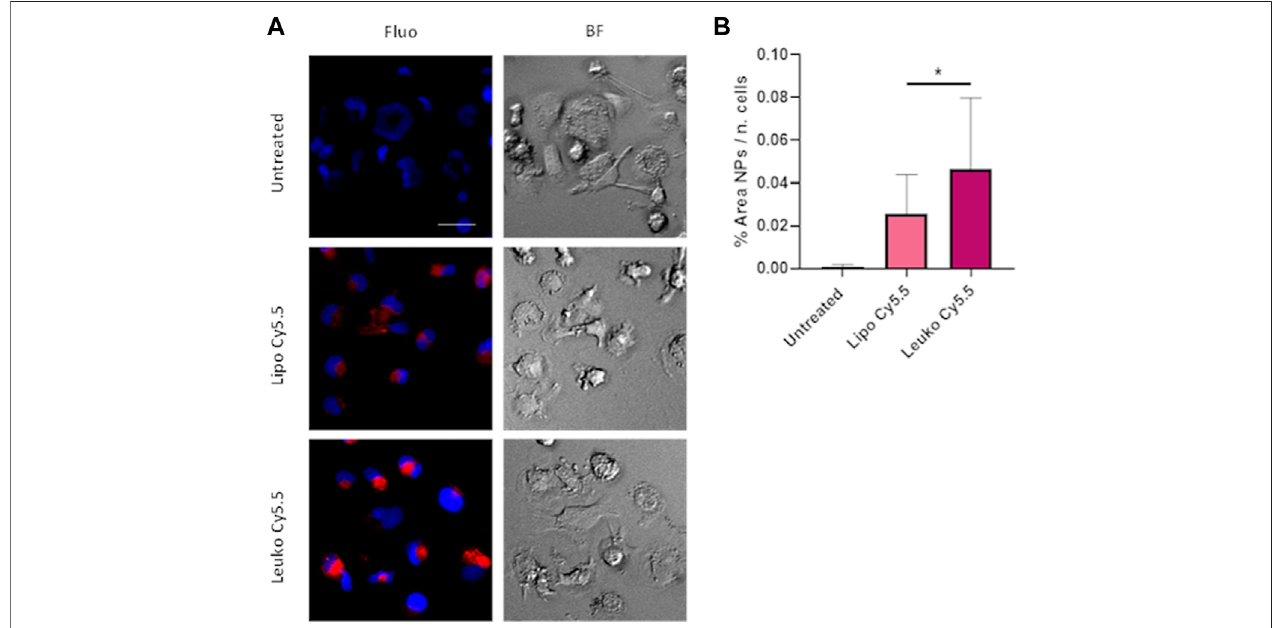
FIGURE 7 | (A) Fluorescence (Fluo) and respective bright fi eld (BF) images of THP-1 derived macrophages treated with either Lipo Cy5.5 or Leuko Cy5.5 for 3 h after treatment with 100 ng/ml of PMA for 48 h. (B) Quanti fi cation of Lipo and Leuko fl uorescence at different time points during uptake. ( p p ˂ 0.05 and n = 3 for all the performed